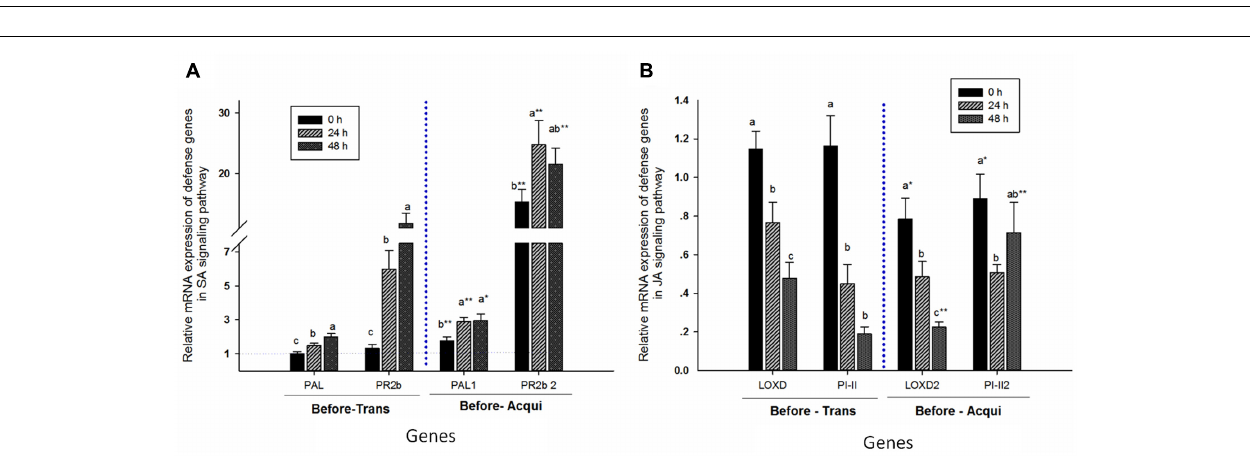
FIGURE 5 | Aphid pre-infestation duration effects on related defense genes in the SA- (A) and JA- (B) signaling pathways in tomato plants. The relative mRNA expression was calculated according to the 2 − (cid:49)(cid:49) C T method, and the y axis represents the level of change. The expression level of each target gene was first normalized to the quantity of SlActin and SlTub . The error bar represents the standard deviation calculated from three replicates. Letters indicate significant differences in relative expression among different aphid pre-infestation durations, and ‘ ∗ ’ indicates significant differences in the same aphid pre-infestation duration according to Duncan’s test at P =